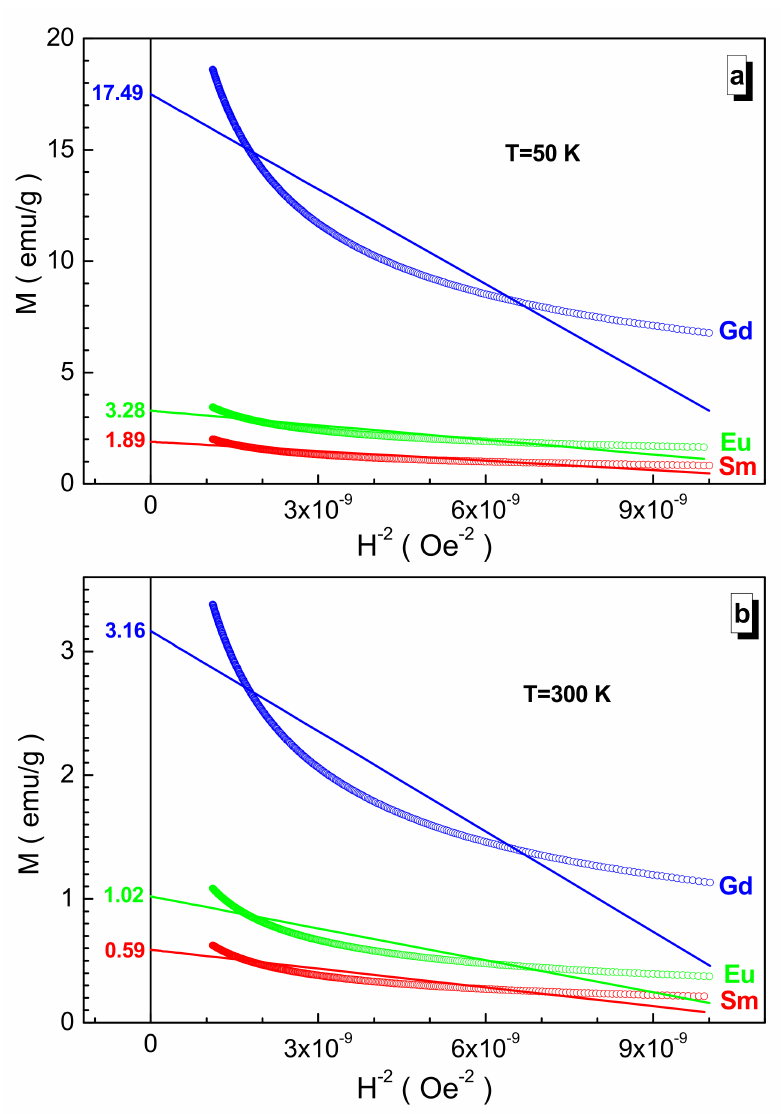
Figure 4. Dependence of magnetization vs. inverse square of the field for the Sm- (red circle), Eu- (green circle), and Gd-based (blue circle) samples at 50 K ( a ) and 300 K ( b ). Straight line is the linear